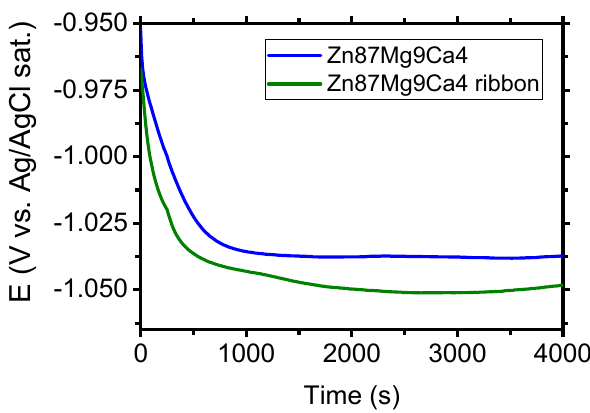
Figure 8. Evolution of OCP for Zn 87 Mg 9 Ca 4 bulk material and Zn 87 Mg 9 Ca 4 ribbon specimens in Ringer’s solution at 37 ° C; pH 7.2 after four thousand seconds.